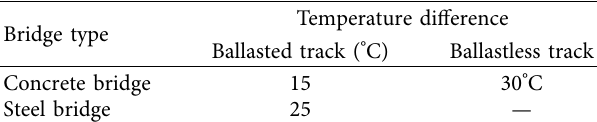
Figure 5: Design of the bridge with CDTWP. Table 4: Temperature difference for the bridge ruled in ‘Code for Design of Railway Continuous Welded Rail (TB 10015–2012)’.